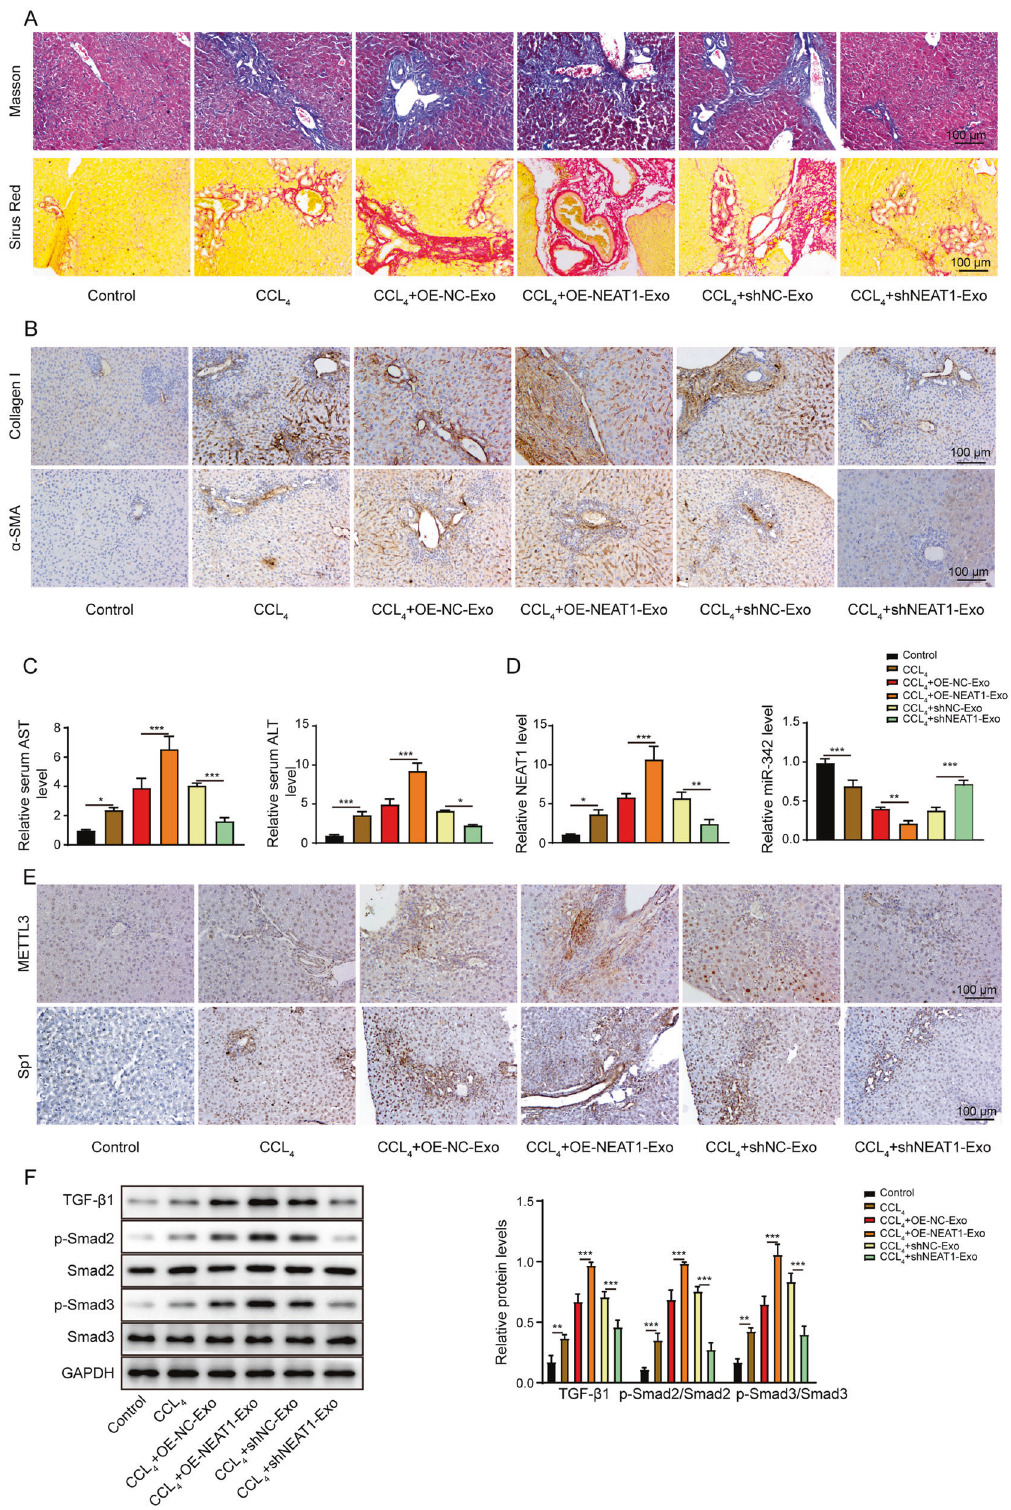
Fig. 10 Exosomal NEAT1 contributes to HF progression in rat. A Representative images of Masson and Sirus Red stainings in liver tissues from Sprague-Dawley rats. Scale bar: 100 μ m. B Representative images of IHC staining of pro- fi brotic factors collagen I and α -SMA in liver tissues from Sprague-Dawley rats. Scale bar: 100 μ m. C ELISA detected serum AST and ALT levels from Sprague-Dawley rats. D qRT-PCR detection of NEAT1 and miR-342 expression levels in liver tissues from Sprague-Dawley rats. E Representative images of IHC staining of METTL3 and Sp1 in liver tissues from Sprague-Dawley rats. Scale bar: 100 μ m. F Western blot results of the expression levels of TGF- β 1, p-Smad2, Smad2, p-Smad3, and Smad3 in liver tissues from Sprague-Dawley rats. * p < 0.05; ** p < 0.01; *** p < 0.001.